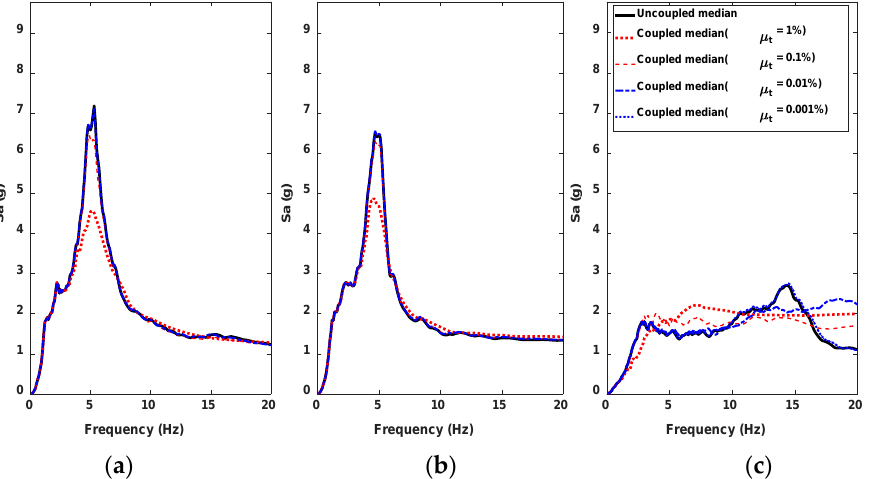
Figure 13. ISRS for 3% equipment damping at the equipment location 2: ( a ) H1; ( b ) H2; ( c ) V.